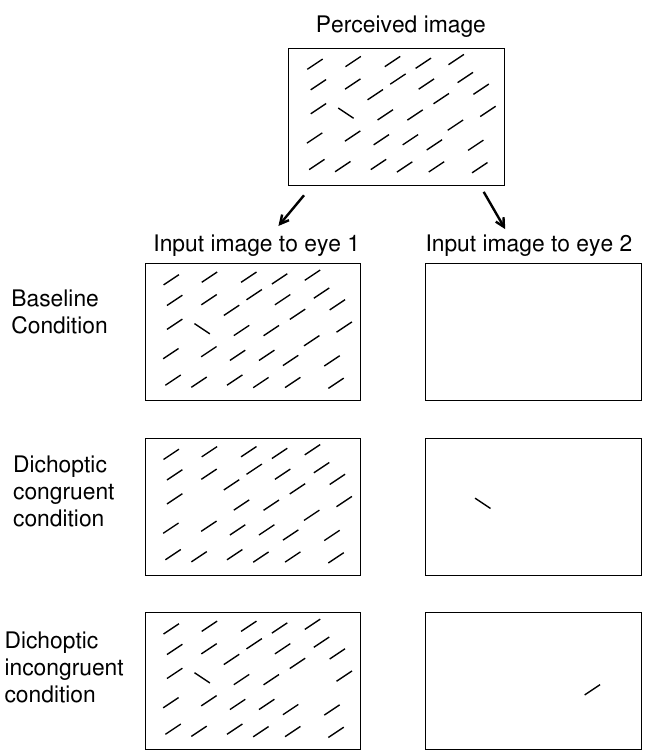
Figure 2. Schematics of the three dichoptic conditions of visual inputs for the visual search task used in the previous [8,9] and the current studies. In this example, the target of the visual search is the uniquely oriented bar. The binocular summation of visual inputs, resembling the perceived image, is the same in these three conditions: baseline, dichoptic congruent (DC), and dichoptic incongruent (DI). In the baseline condition, all the relevant visual items are presented monocularly to the same eye. In the dichoptic congruent (DC) condition, the search target is presented to one eye, and all the non-targets are presented to the other eye; this target is thus an eye-of-origin singleton, or an ocularity singleton. In the dichoptic incongruent (DI) condition, the ocularity singleton is in the right half of the perceived image, while the target is in the left half, or vice